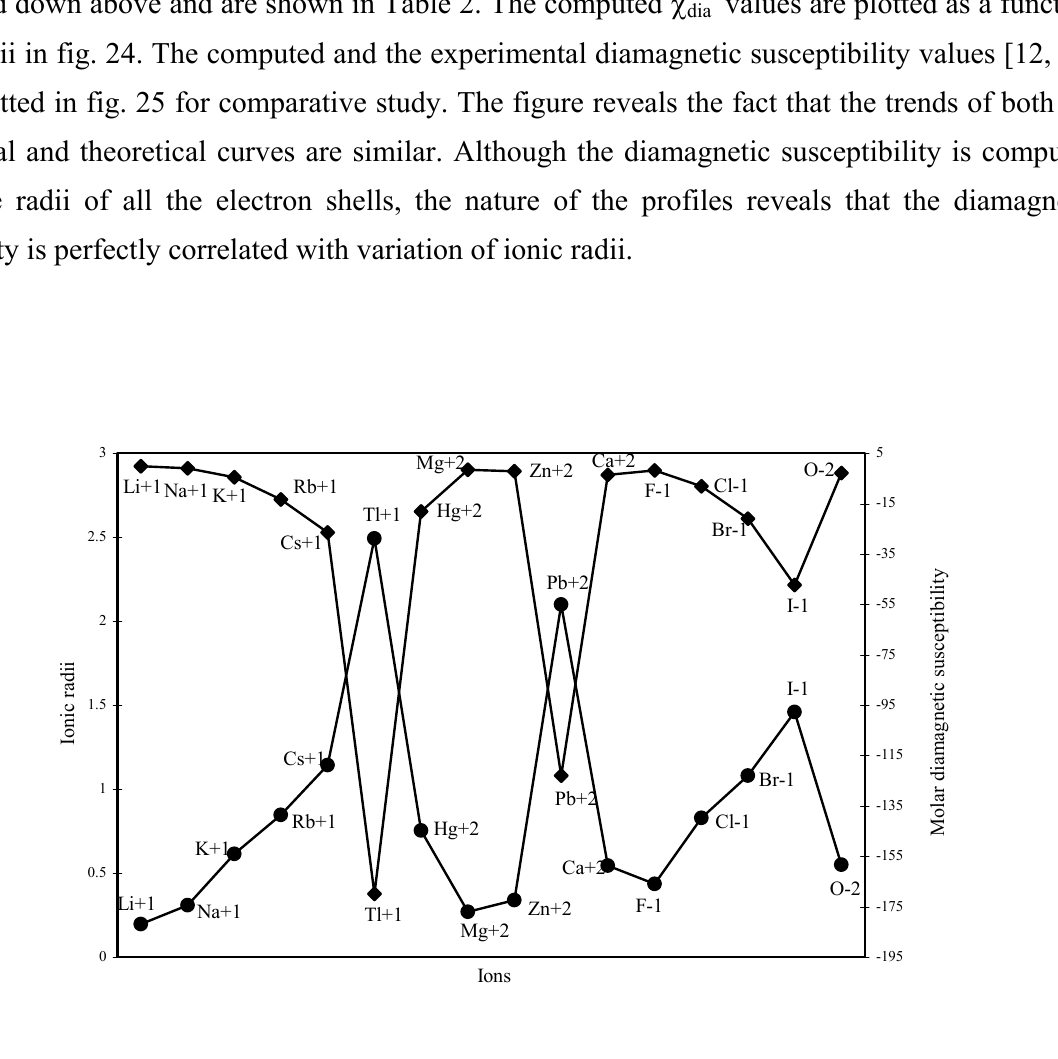
Figure 24 . Plot of radii and molar diamagnetic susceptibility of